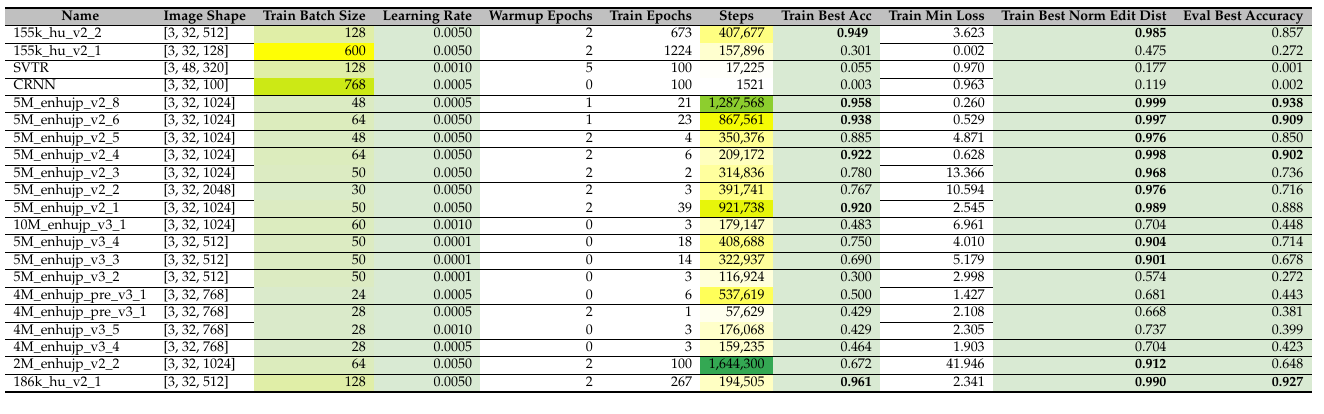
Table 5. Results and accuracy.